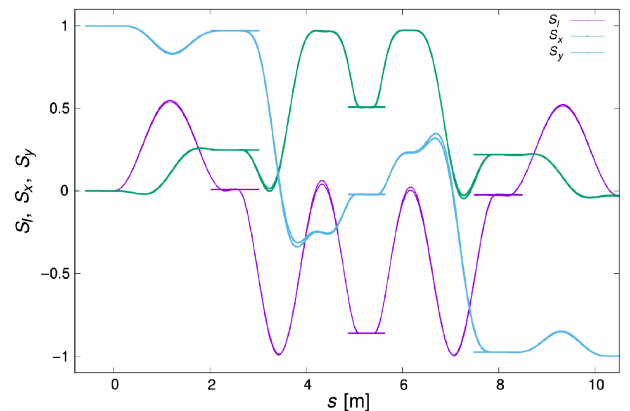
FIG. 8. Evolution of the spin components along the helical trajectories of Fig. 7 (from vertical initial spin), at 23 and 250 GeV. It can be observed that spin motion across the snake is essentially independent of energy, as expected: except for the 3 – 7 m region where the 23- and 250-GeV S y components do not ⃗ S ð s Þ fully coincide, the components at both energies essentially superimpose at this scale. The small back-forth segments at helix ends are field map manipulation artifacts.